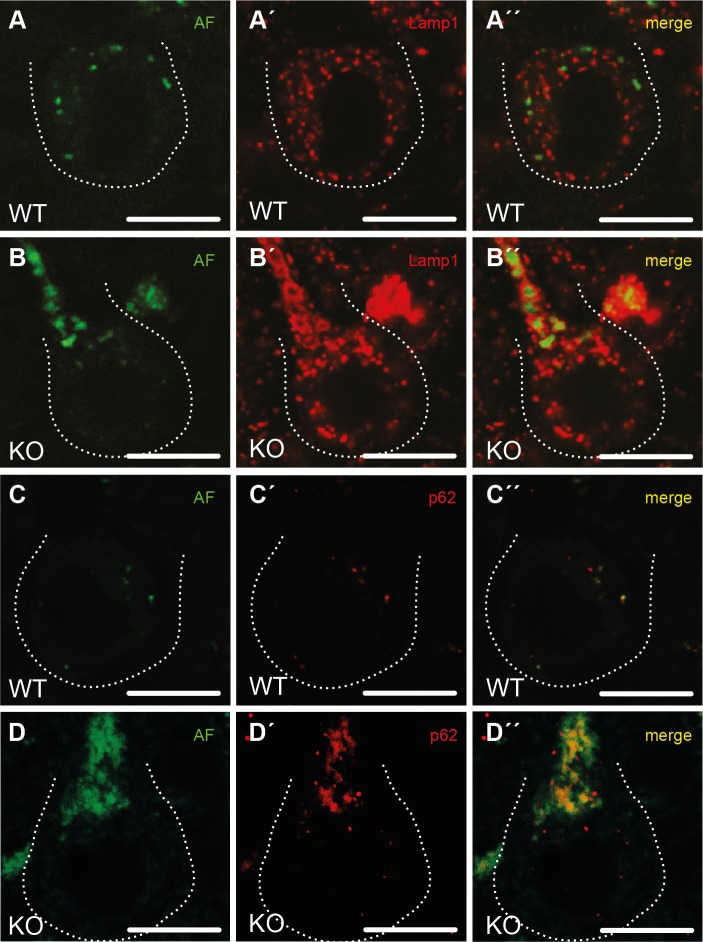
Purkinje cells in Spatacsin knockout mice accumulate abnormal autolysosomes.
(A-B”) While the small autofluorescent particles (AF) in WT Purkinje cells (A”) are rarely associated with the lysosomal membrane protein Lamp1, autofluorescent structures in KO Purkinje cells stain for Lamp1 at their periphery (B”). (C-D”) The autofluorescent material in KO Purkinje cells contains p62 (D”) suggesting that the vesicular structures positive for both Lamp1 and p62 represent autolysosomes. Purkinje cell somata are marked by a dashed line. Age at sampling: 16 months. AF: autofluorescence; Scale bars: 10 μm.